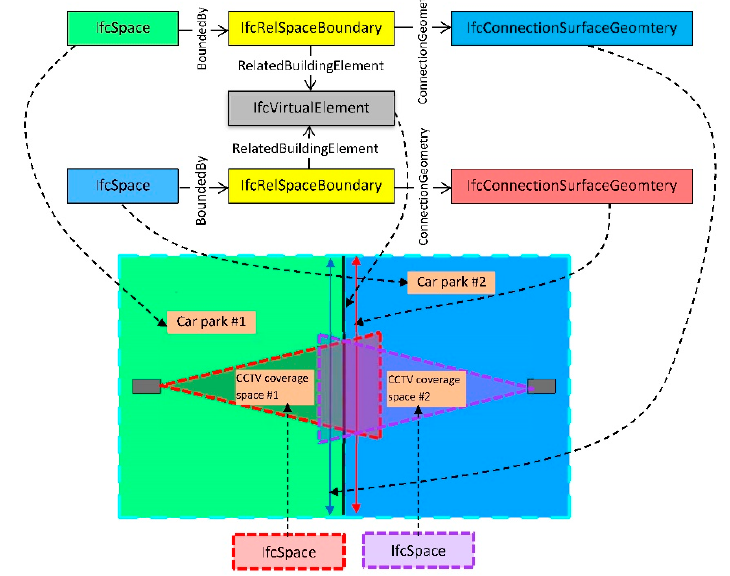
Figure 7. Mapping the field of view for two CCTV cameras and ownership spaces for two car parks in IFC.